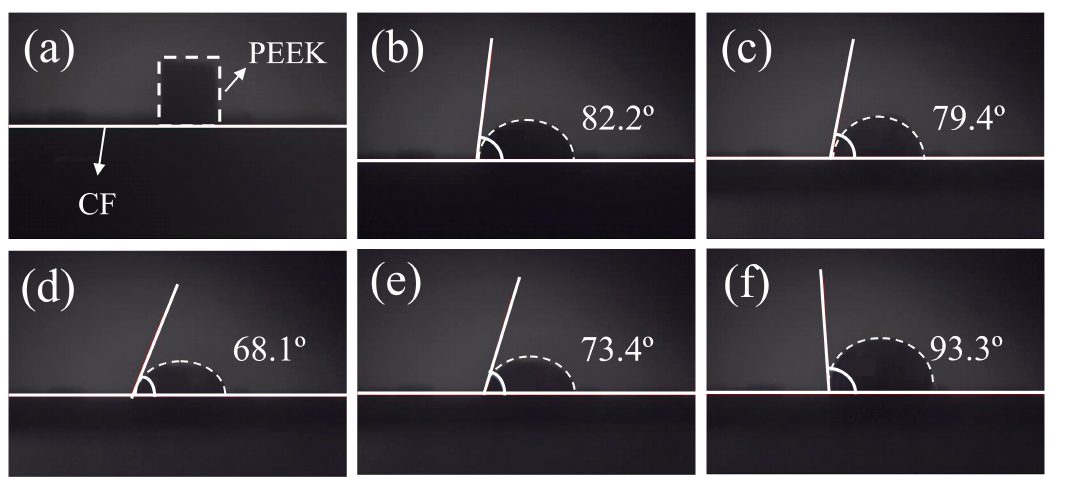
Figure 4. Static contact angles of PEEK on CFs under different temperatures: ( a ) 25 °C; ( b ) 360 °C; ( c ) 365 °C; ( d ) 370 °C; ( e ) 375 °C; ( f ) 380 °C.